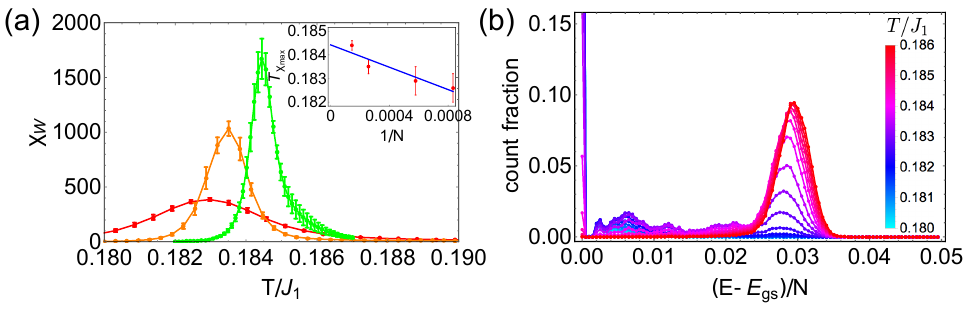
[ Eq. 1 ] . (a) The winding dip / J = 0.1845 ± 0.0010. 1 1 and energy bins have width 0.0005 J . A sharp 1 1 1